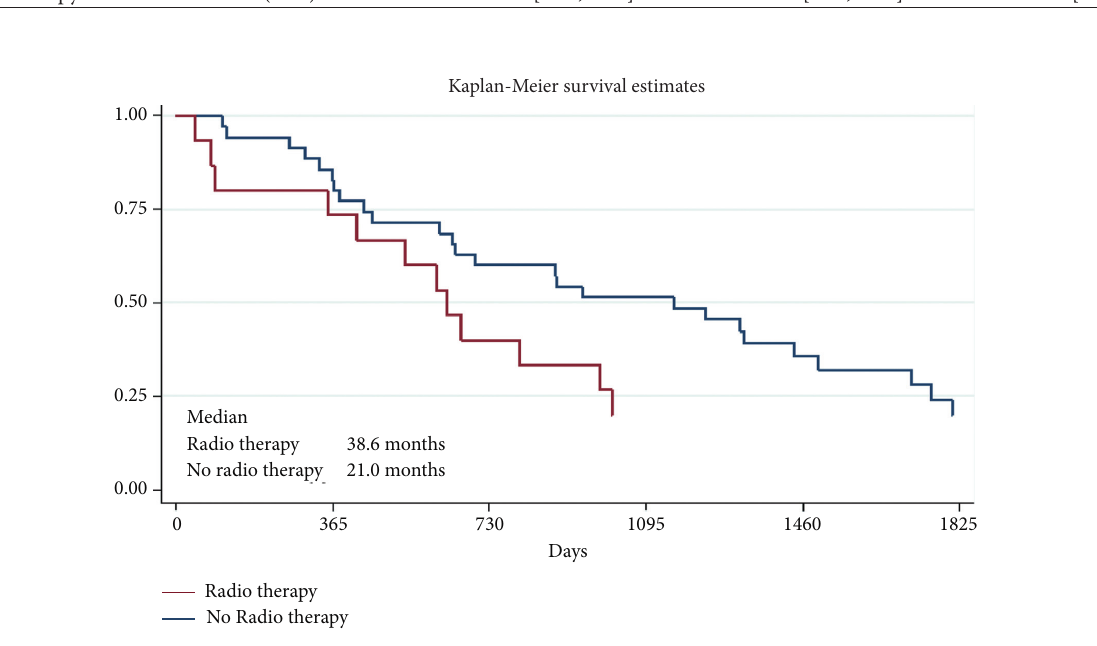
Figure 3: Survival results of the patients treated by radiotherapy ( p � 0 . 34). Table 8: Survival results of the patients treated by systemic therapy.